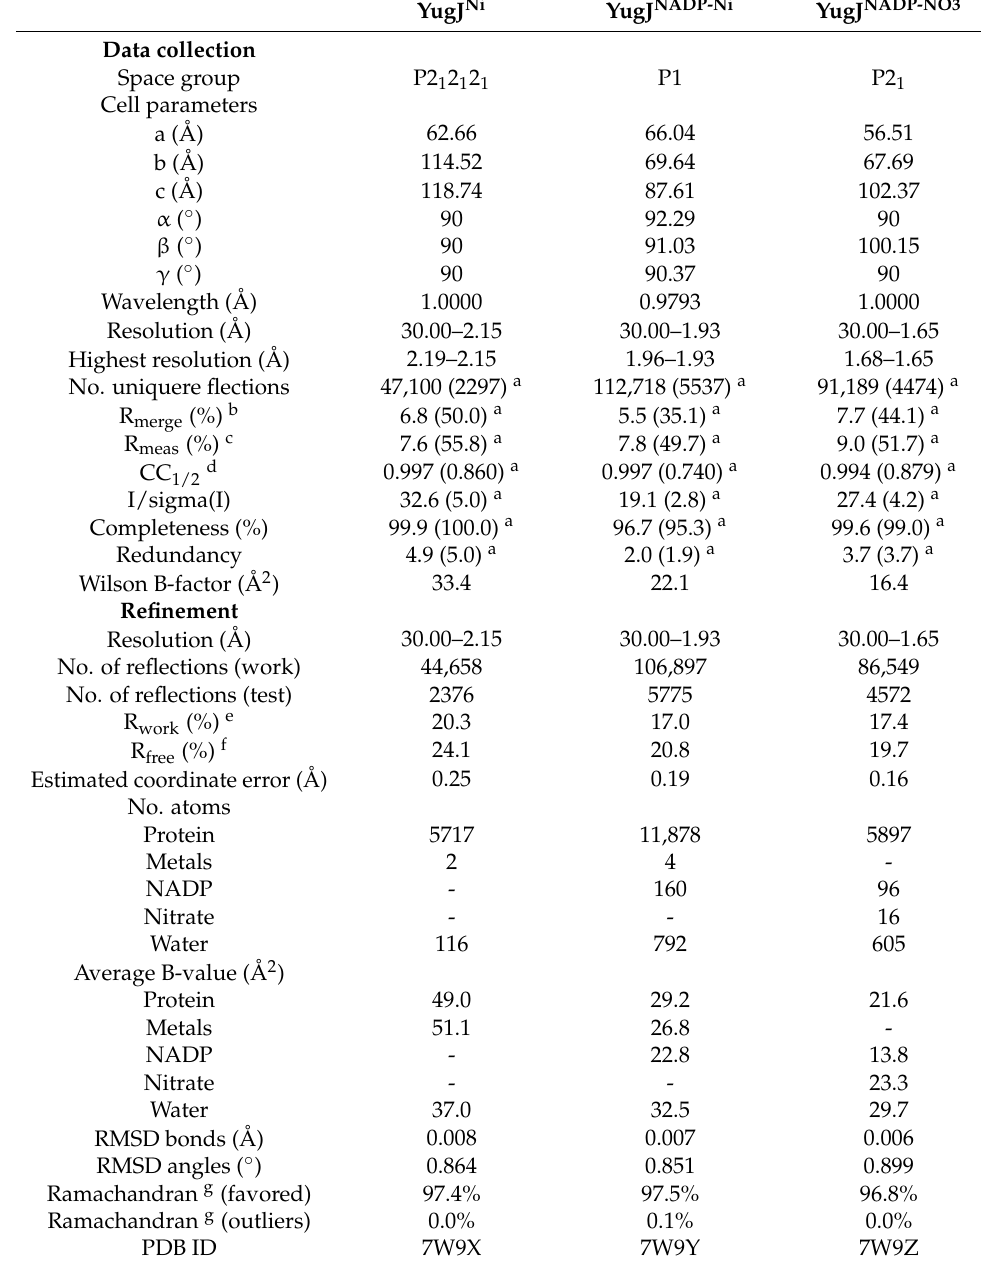
Table 1. Crystallographic statistics of the YugJ